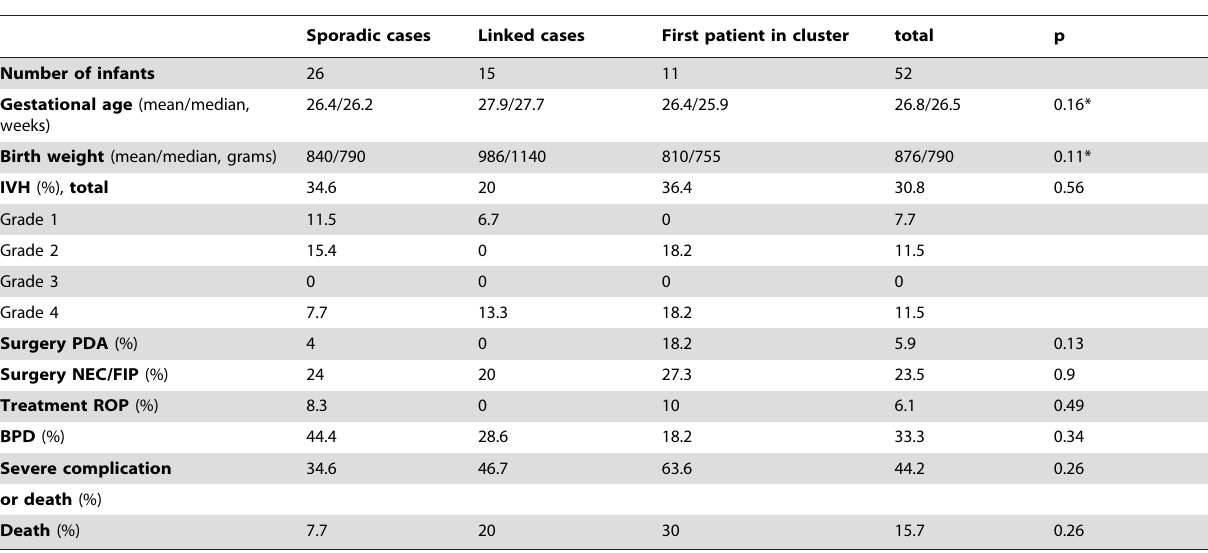
Table 3. Outcome of patients in microclusters of blood-culture proven